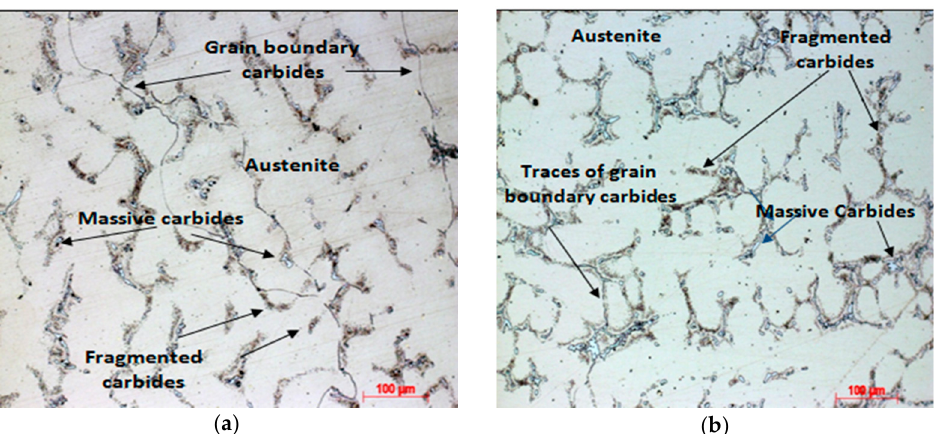
Figure 4. ( a ) Microstructure obtained after solution annealing at 1200 °C for 1.5 h followed by water quenching; ( b ) Sample solution annealed at 1200 °C for 3 h followed by water quenching.